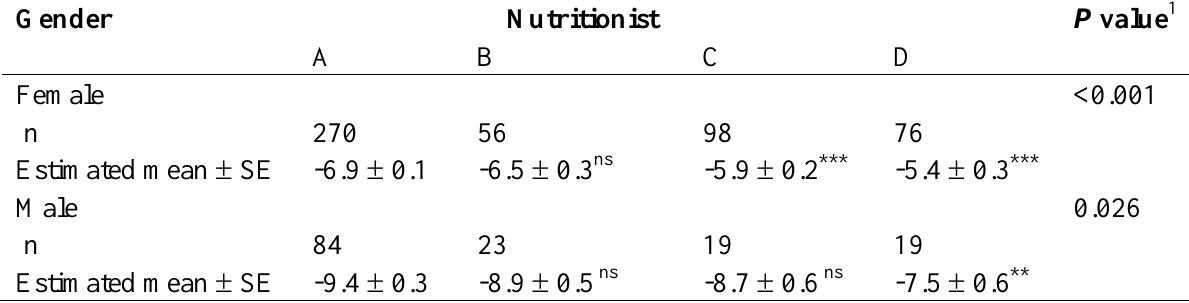
Table 3. Effect of nutritionist variation on weight change during the LMP by gender.